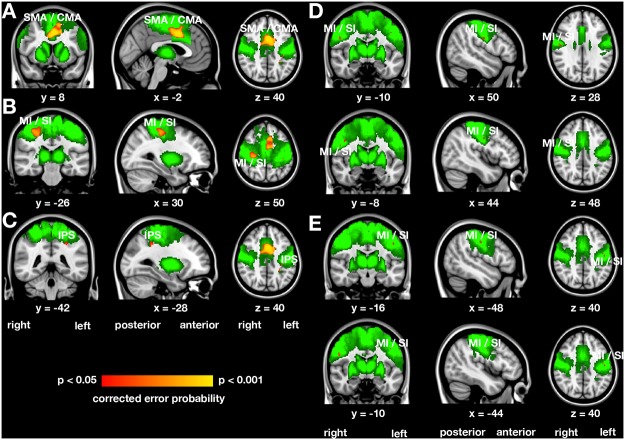
Regions with altered probabilistic grey volume in the somatosensory-motor cortex of handball players derived from the voxel-based morphometric group analysis (A-C) and the correlation analysis (D and E).The statistical parametric maps (shown in red yellow) were height-thresholded at p < 0.05 corrected for multiple comparisons using permutation-based non-parametric testing across space (FSL’s randomise tool, 5000 permutations). Increased grey matter volume was evident (A) in the bilateral supplementary motor area (SMA) and cingulate motor area (CMA) and (B) in the right primary motor and somatosensory cortex (MI and SI) and (C) in the left intraparietal sulcus (IPS). Age of handball training commencement was negatively correlated with grey matter volume in four small clusters, two clusters located in the right MI/SI region (D) and two clusters located in the left MI/SI region (E). The regions of interest subjected to the statistical analysis are shown in graded green. x, y, z represent coordinates of the Montreal neurological institute (MNI) stereotactic space.